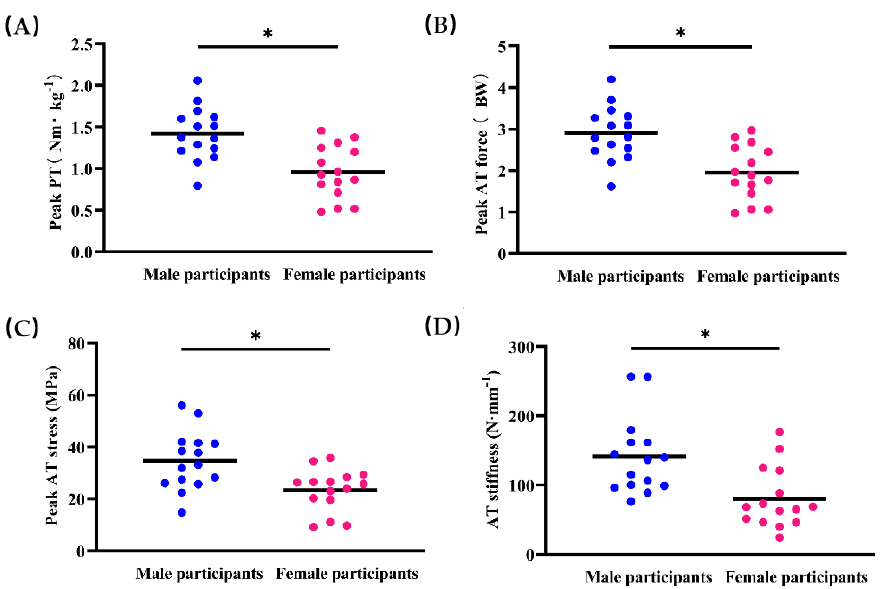
Figure 4. Differences in peak plantarflexion torque (PT, A ), Achilles tendon (AT) force ( B ), stress ( C ), and stiffness ( D ) between male and female participants. * Indicates p < 0.05.